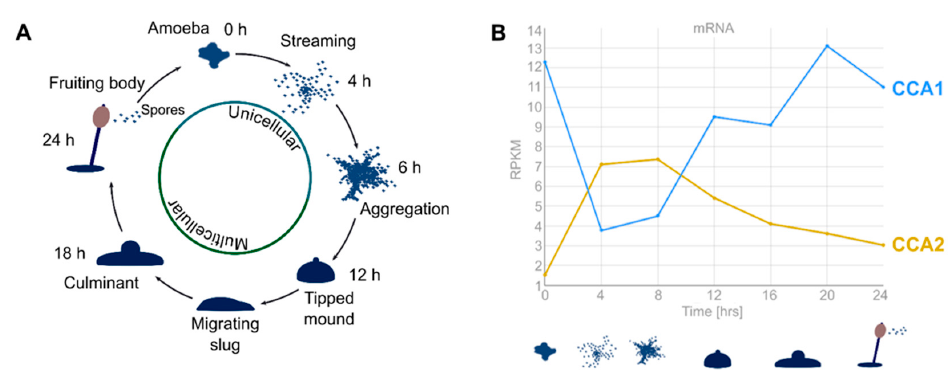
Figure 2. Subcellular localization of CCA1 and CCA2 enzymes. Full length CCA1 and CCA2 enzymes fused to GFP (( A ): GFP-CCA1; ( B ): GFP-CCA2) were overexpressed in wild-type Dictyostelium cells and show a cytosolic distribution but no specific enrichment within mitochondria (red, stained with MitoTrackerRed). Size bar represents 5 µm.